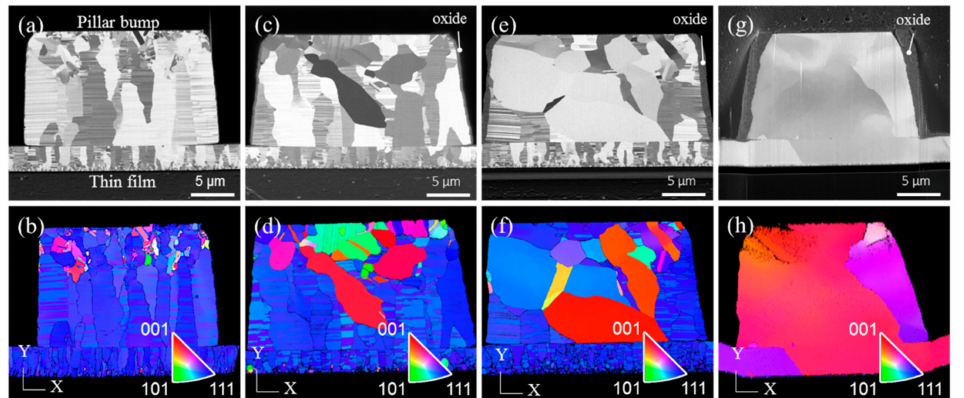
Figure 2. Cross-sectional focused ion beam (FIB) and electron backscatter diffraction (EBSD) images showing grain growth in the Cu joints bonded at various temperatures. ( a ) FIB image, 200 ◦ C/100 ◦ C; ( b ) EBSD image for the joint in (a); ( c ) FIB image, 250 ◦ C/100 ◦ C; ( d ) EBSD image for the joint in (c); ( e ) FIB image, 300 ◦ C/100 ◦ C; ( f ) EBSD image for the joint in (e); ( g ) FIB image, 350 ◦ C/100 ◦ C; and ( h ) EBSD image for the joint in